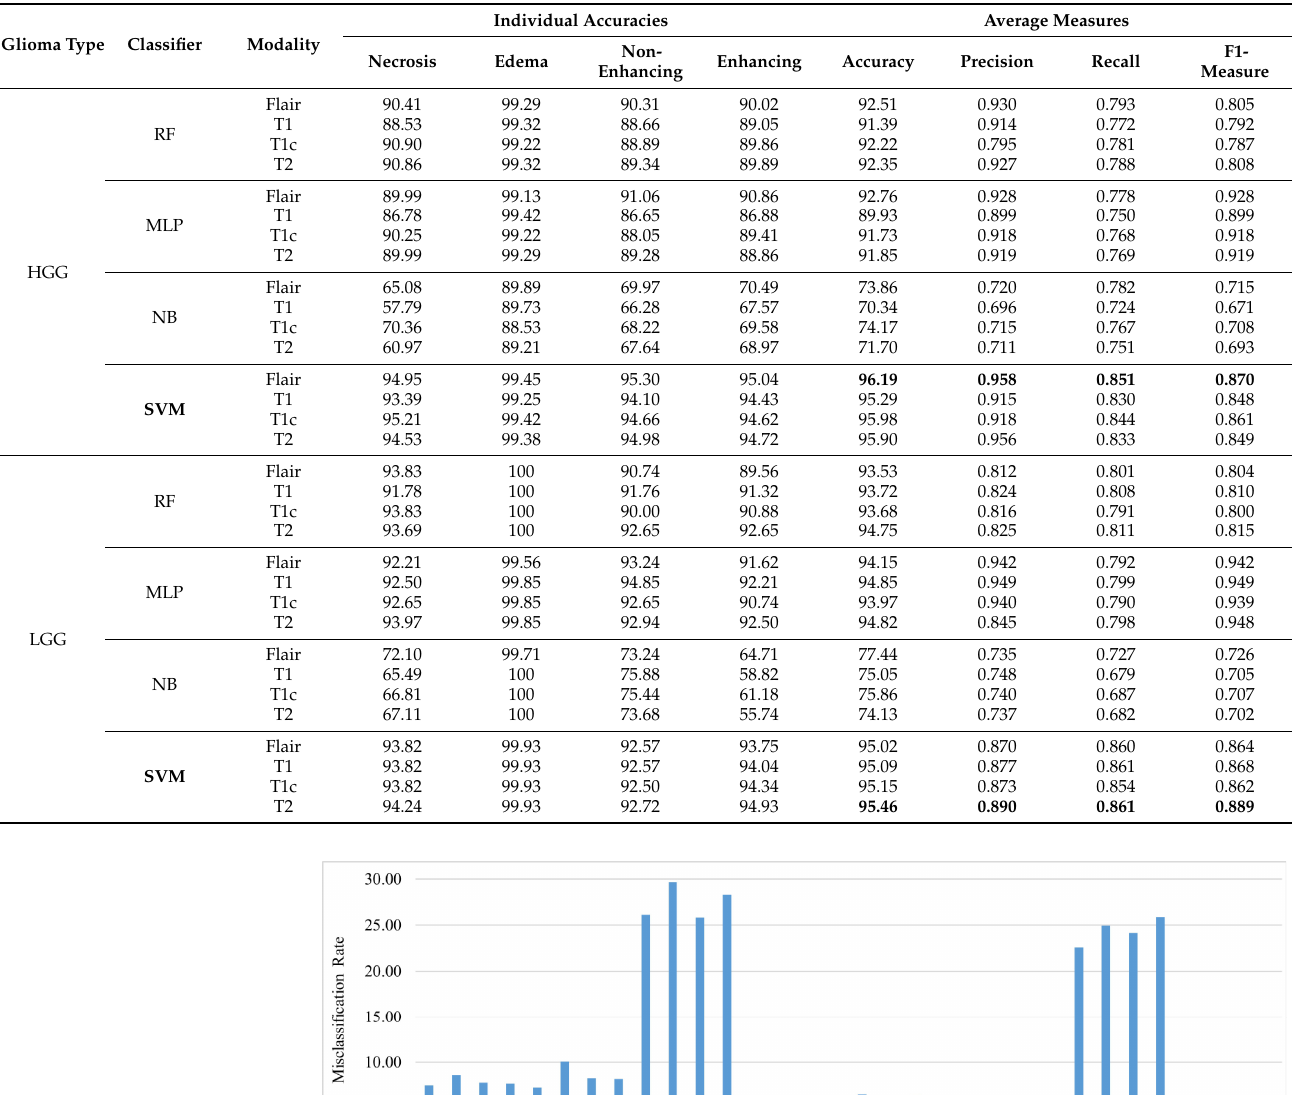
Table 1. Comparison of Multi-class Glioma Tumor Classification using CNN Features with typi- cal Classifiers.